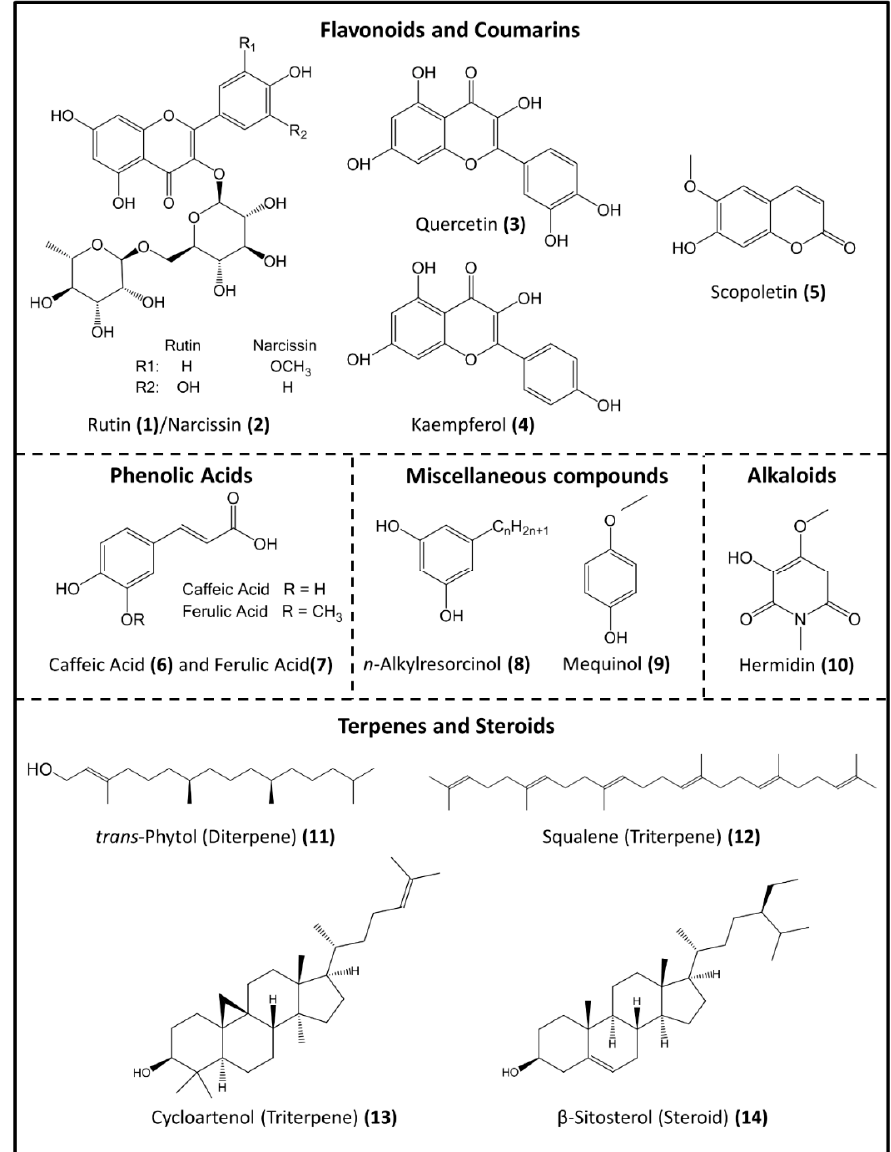
Figure 2. Chemical structures of the main bioactive phytochemicals in Mercurialis spp. (from PubChem [44]).